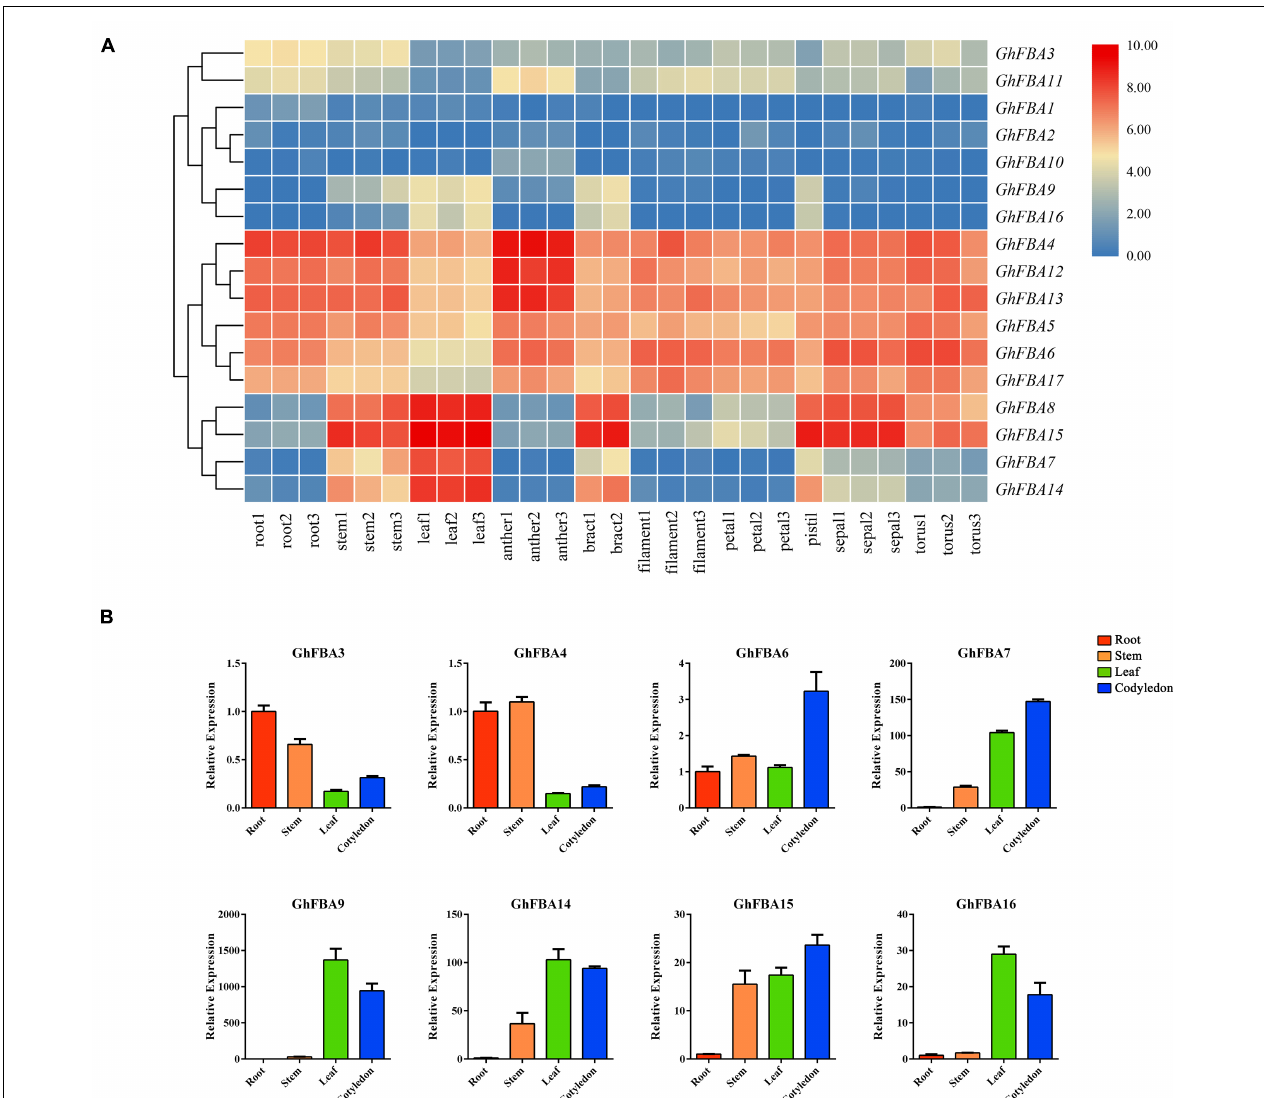
FIGURE 6 | Expression profiles of the GhFBA genes in various tissues. (A) Hierachical clustering of expression profiles of GhFBA genes in various tissues. The TPM values were perform treatment of log 2 (TPM + 1), then the results were used to visualize the heatmap. (B) Expression analysis of eight representative GhFBA genes in different tissues by qRT-PCR, and GhHIS gene was used as a reference gene, vertical bars indicate standard